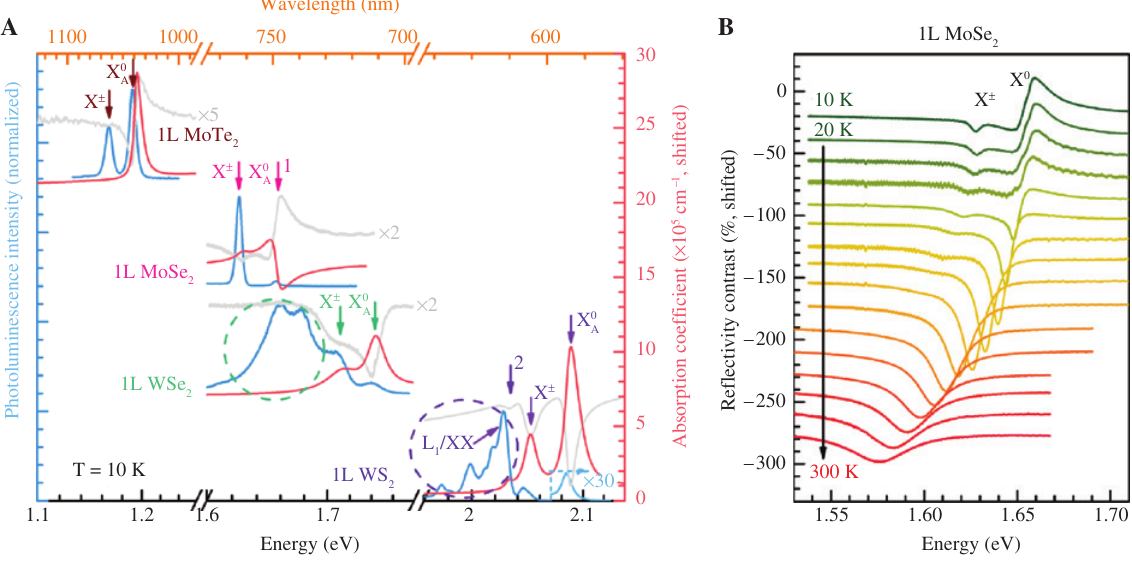
Figure 3: Near band edge optical response of S-TMD monolayers. (A) Photoluminescence (blue, normalized, left y -axis) and absorption spectra (red, right y -axis) of monolayers of WS [11], and MoTe [13] in the energy region in the vicinity of A exciton. Absorption spectra have been derived from the transfer matrix based 2 analysis of the measured reflectance-contrast spectra (light grey, amplified with factors mentioned along with them). The neutral 0 charged (X ± ) A exciton transitions have been marked. The spectra for WSe The dashed circles highlight peculiar emission from WS Fano-like and defect-related absorption peaks in monolayer MoSe function of temperature, in steps of 20 K, depicting the evolution of Fano-type resonance at low temperature, to a vanishing Fano-like effect at higher temperature